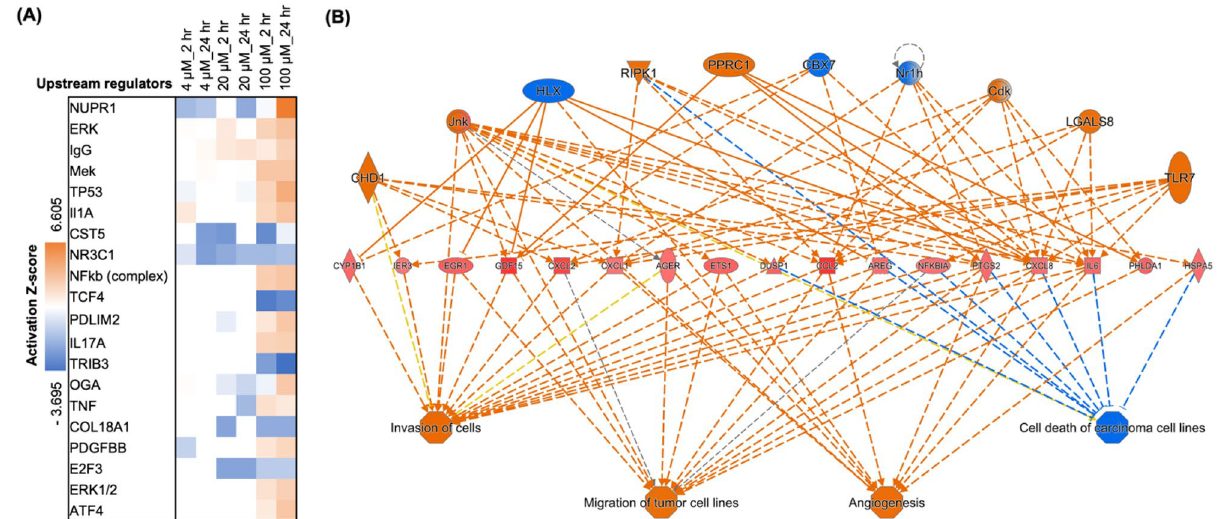
Figure 4. IPA upstream regulators and functions based on RNA-seq of TDCPP-treated HeLa cells with absolute Z-score ≥ 2 at least in one condition and −log(p-value) ≥ 1.3. (A) Top 20 upstream regulators in the group Control vs. Treatment. Results based on fold change values calculated by comparing gene expression in 6 treatment conditions to control. Positive Z-score indicates activation, and a negative score indicates inhibition. (B) Regulator effects of 2 most consistent networks based on RNA-seq of TDCPP treated HeLa cells. Both networks were constructed using data from 100 µM, 2 h/control (consistency score equal to